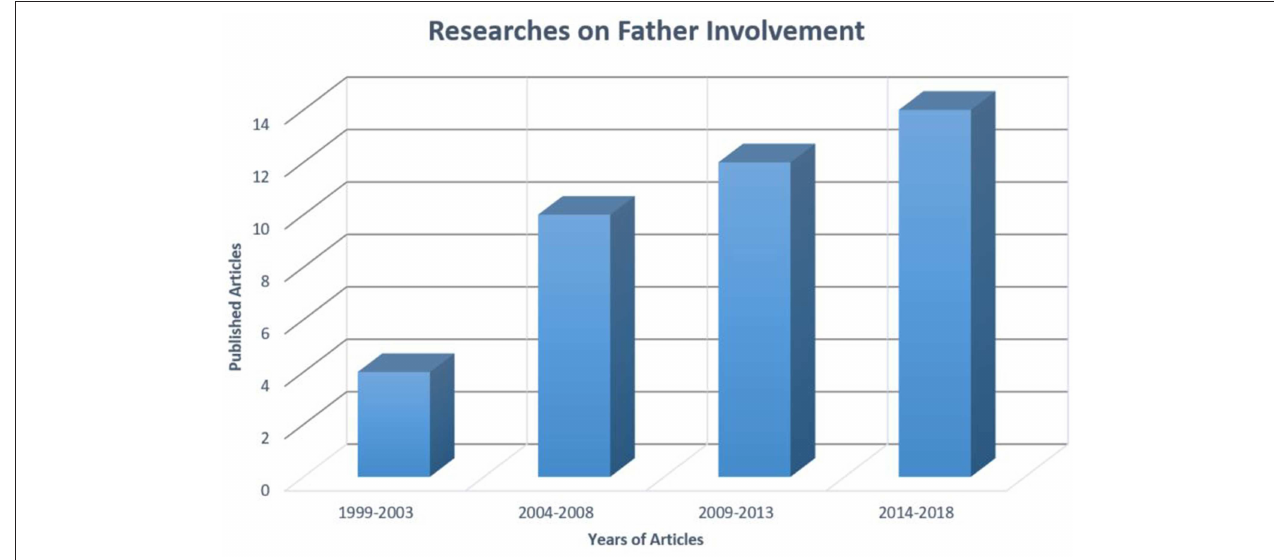
FIGURE 2 | Published articles (included in this review) across years.